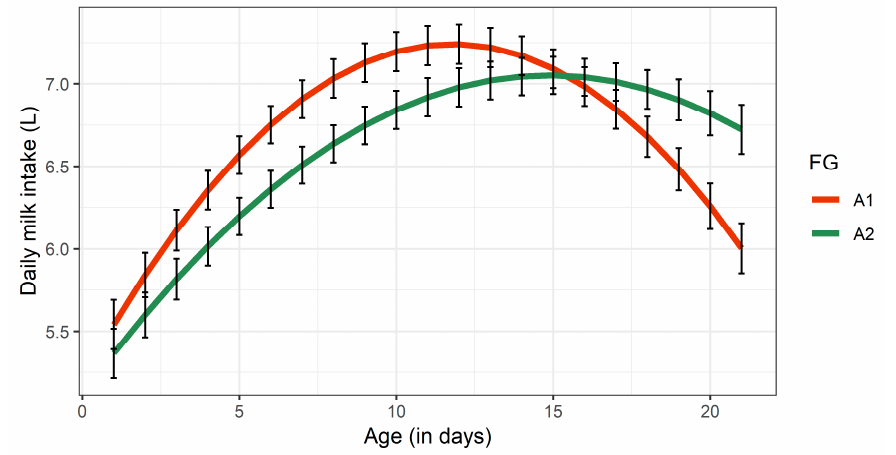
Figure 1. Least squares means for daily milk intake of calves receiving either A1- or A2-milk during the experimental period of 21 days. Black bars indicate standard errors. FG, feeding group.